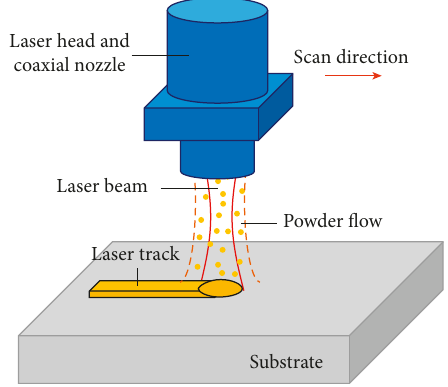
Figure 3: Schematic diagram of laser cladding